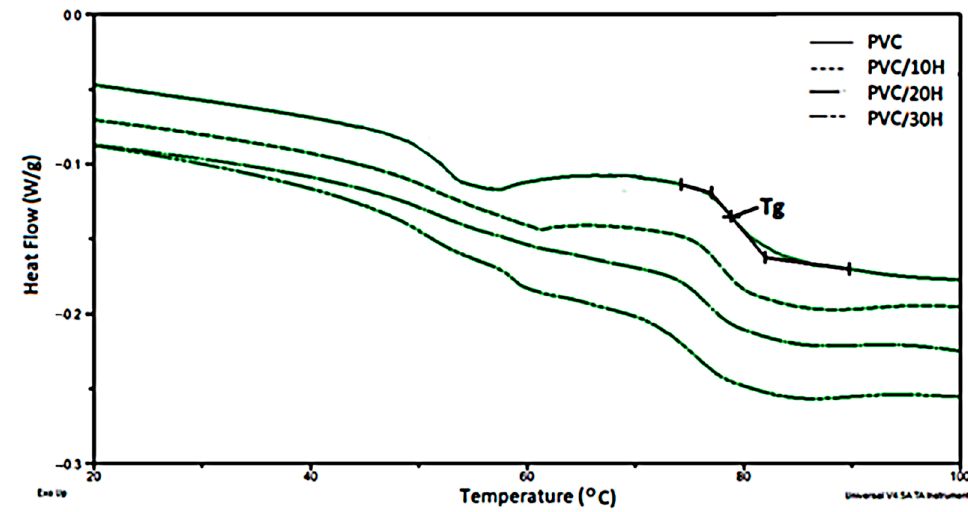
Figure 6. DSC thermograms of PVC and PVC